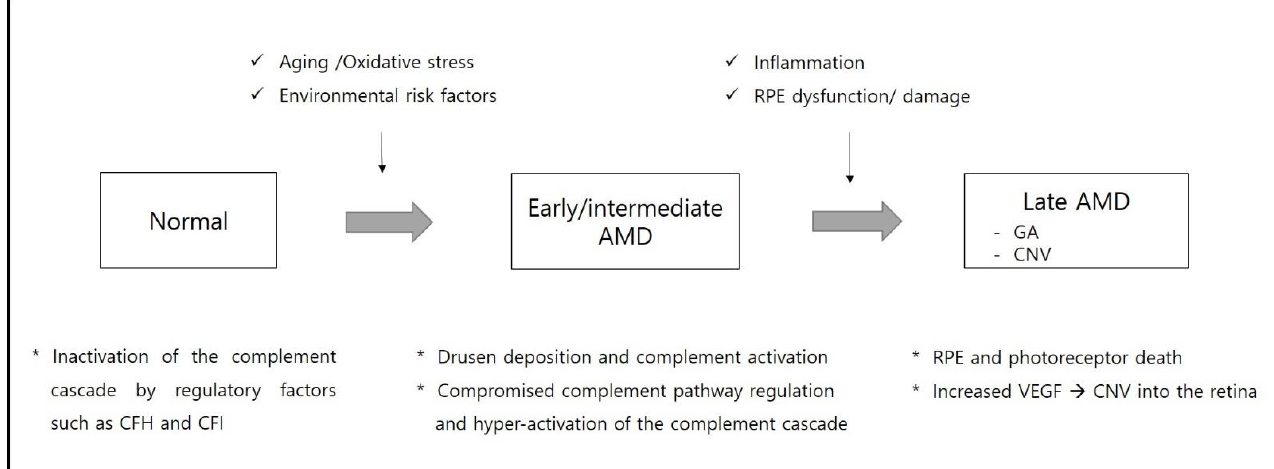
Figure 4. Schematic representation of the pathogenesis from early to late stages of age-related macular degeneration (AMD). CFH, complement factor H; CFI, complement factor I; CNV, choroidal neovascularization; GA, geographic atrophy; RPE, retinal pigmented epithelium; VEGF, vascular endothelial growth factor.